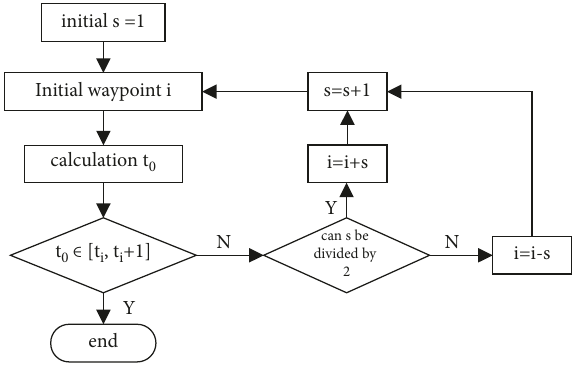
Figure 7: Flowchart of segment point t